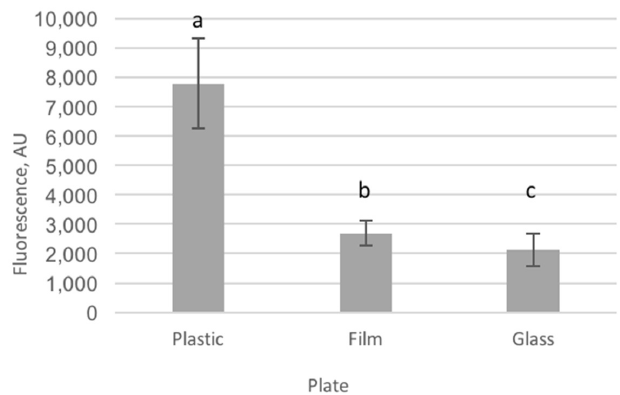
Figure 2. Autofluorescence of the three tested cell culture plates, differing in the material used in the bottom (plastic: polystyrene cell culture microplate Clear ® (Greiner Bio-One, Vilvoorde, Belgium); film: cell imaging microplate 25-µm film bottom (Eppendorf, Aarschot, Belgium) and glass: cell imaging microplate 170-µm coverglass bottom (Eppendorf)). Fluorescence intensity is represented in arbitrary units (AU). Plastic-bottomed plates show the highest autofluorescence values, while glass-bottomed plates showed the lowest. Film-bottomed plates showed intermediate autofluorescence that statistically differed from the two former plate types. Different letters denote values that are significantly different.